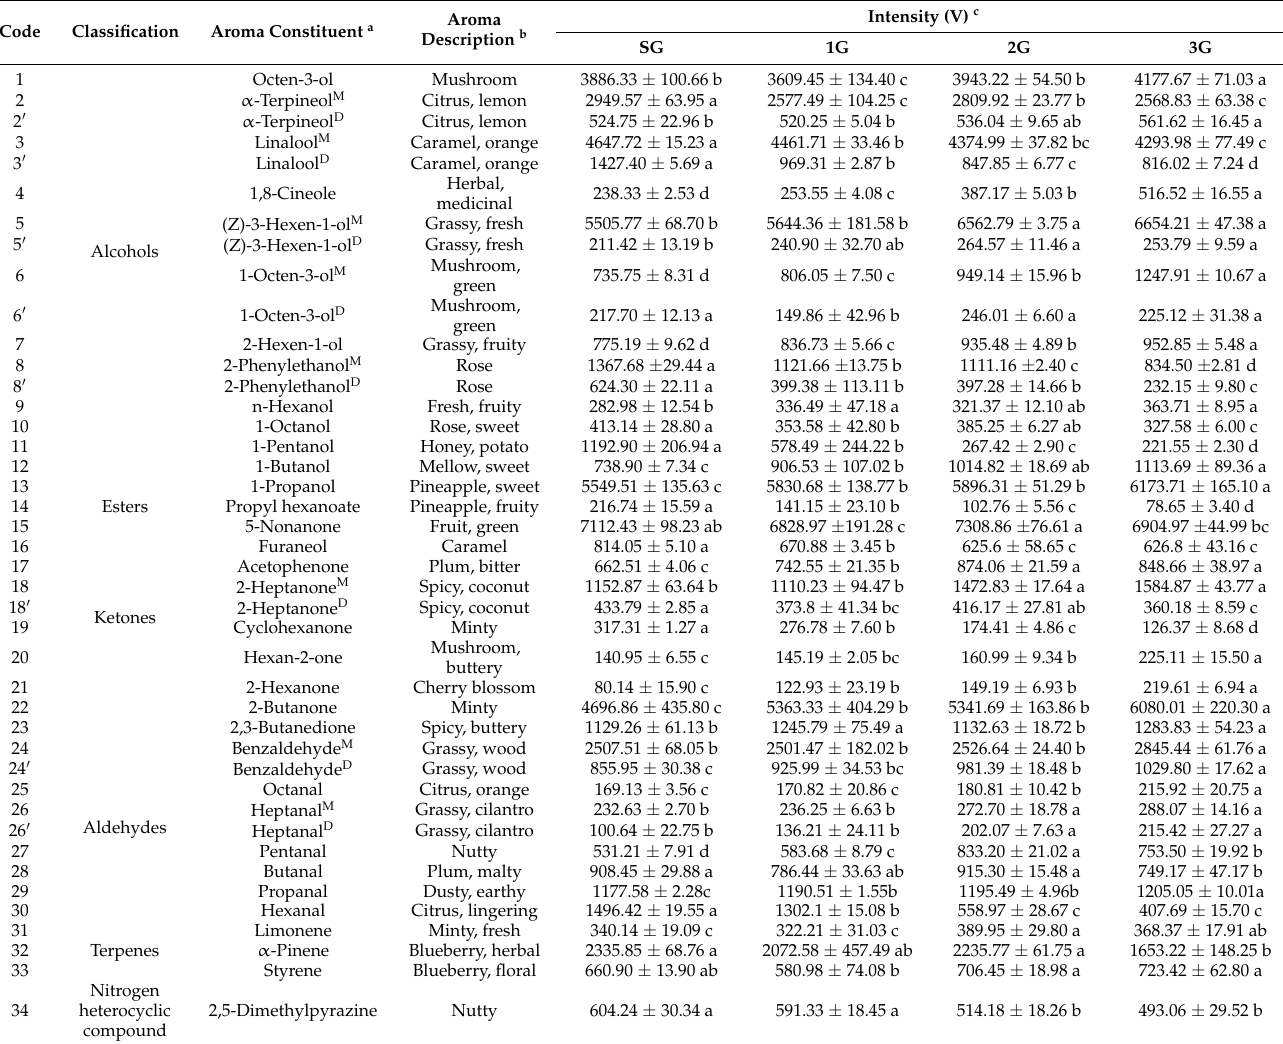
Table 4. The identification of VOCs in four grades of PCT based on